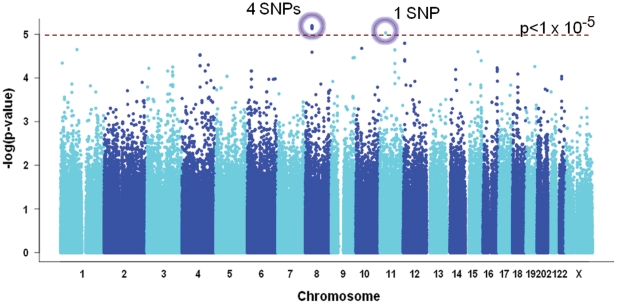
Manhattan plot of GWA study results of testing for association with HBV-related HCC susceptibility.The dotted line indicates the p-value threshold of 1×10−5. The circled SNPs are those passing the threshold (Table 1).